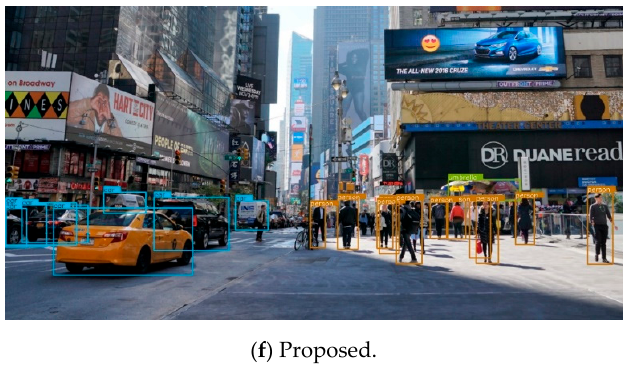
Figure 7. Performance comparison for detection of vehicles and people in city scenes.